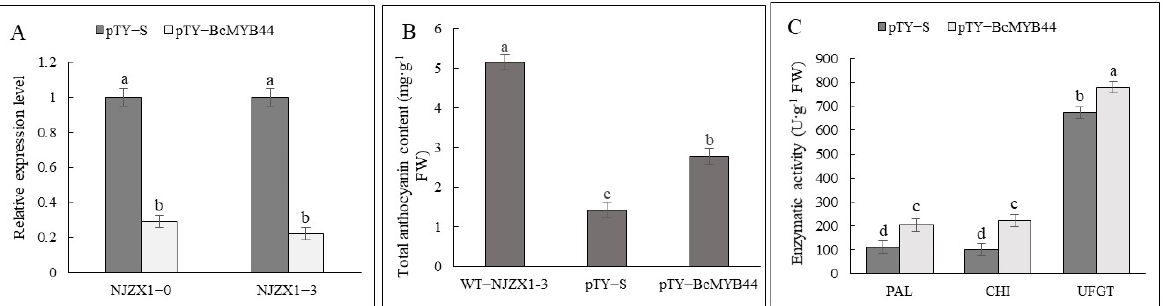
Figure 7. Phenotypic changes of non-heading Chinese cabbage materials after VIGS treatment. From left to right were WT, pTY-BcMYB44, pTY-S of ‘NJZX1-3’; WT, pTY-BcMYB44, pTY-S of ‘NJZX1- 0’.(WT: wild type; pTY-BcMYB44: gene scilencing plant; pTY-S: empty vector plant.)